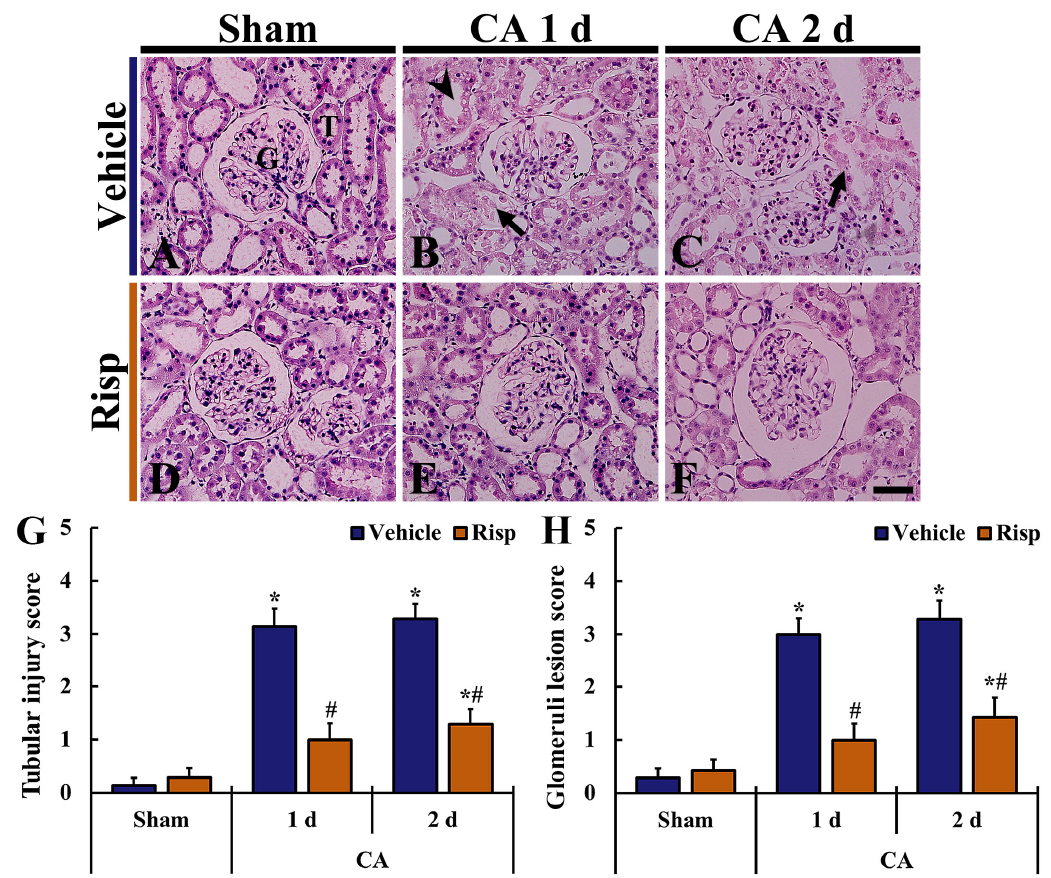
Figure 4. HE staining in the kidney of the Sham-vehicle ( A ), CA-vehicle ( B , C ), CA-Risp ( D ), and CA-Risp ( E , F ) groups one day and two days after CA/ROSC. In the rats of CA-vehicle group, the patchy denudation of renal tubular cells with loss of brush border (arrows), vacuoles in tubular cells (arrowheads), and tubular dilation are shown, which are more severe at 48 h after CA/ROSC. In the rats of the CA-Risp group, however, the CA/ROSC-induced alterations are apparently attenuated. G, glomerulus; T, tubule. Scale bar = 100 μm. ( G , H ) Tubular injury score ( G ) and glomeruli lesion score ( H ). The bars indicate the means ± SEM ( n = 7, respectively; * p < 0.05 vs. Sham-vehicle group; # p < 0.05 vs. CA-vehicle group).